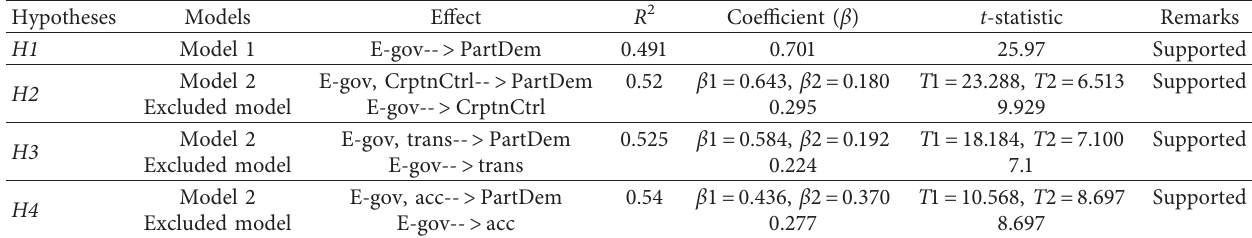
Table 6: Hypotheses testing results.